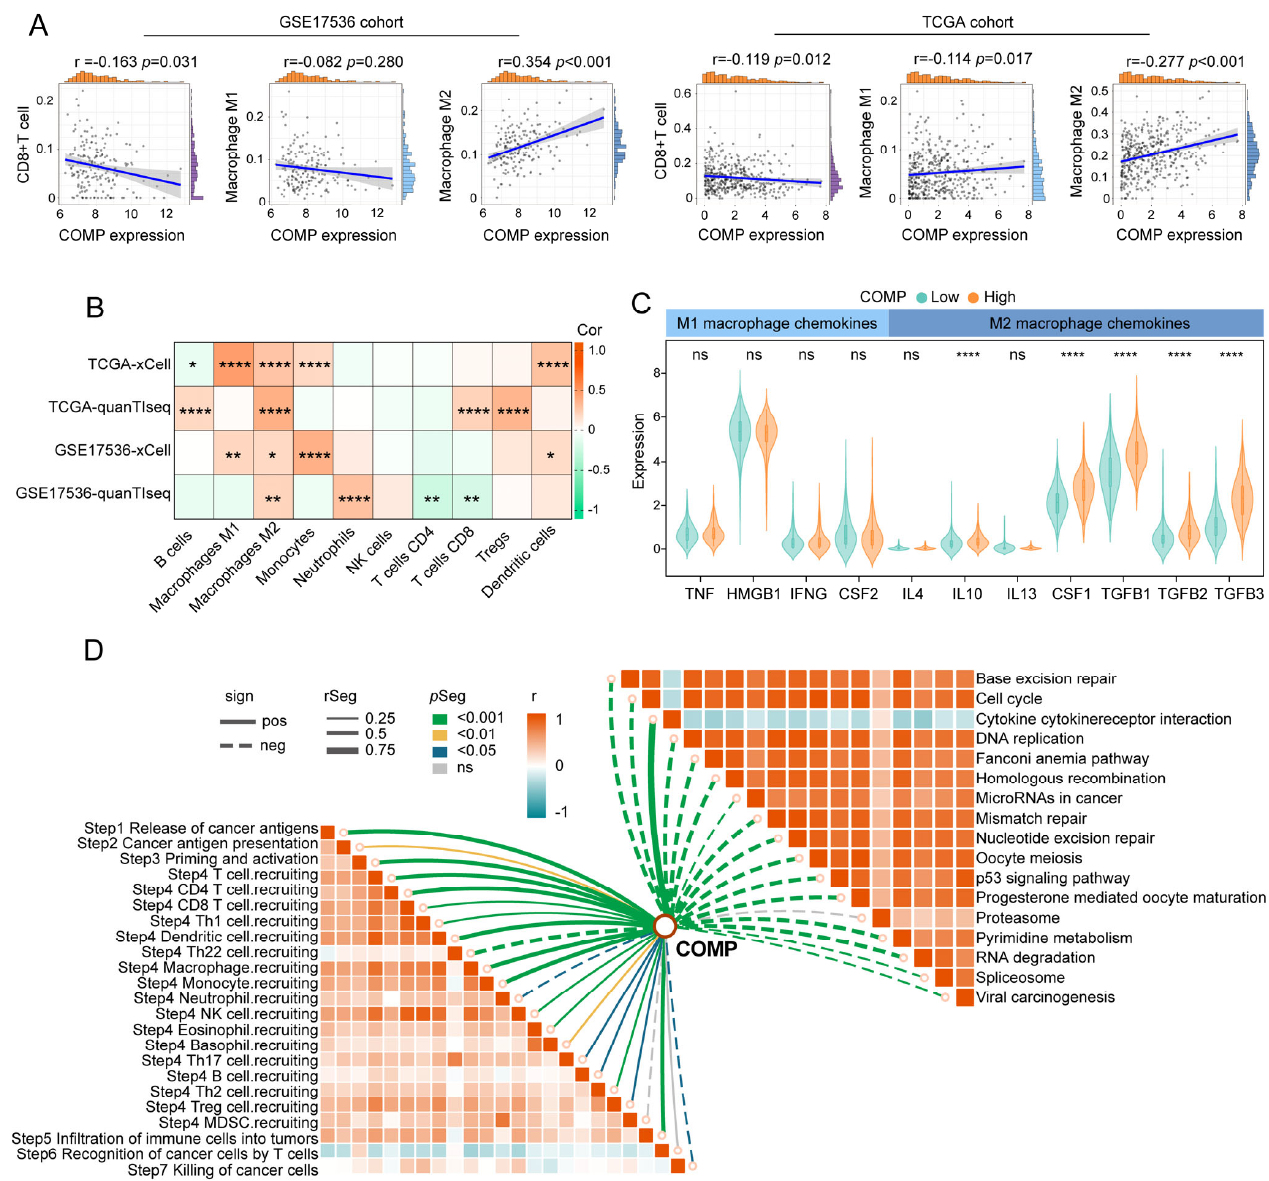
Figure 4. The immune landscape of COMP in colon cancer. ( A ) Correlations between COMP expression with CD8+T cells, M1 and M2 macrophage infiltration levels in the TCGA and GSE17536 datasets; ( B ) Heat map illustrating correlations between COMP expression and the infiltration levels of 10 immune cells estimated using xCell and quanTIseq algorithms; ( C ) Expression of representative macrophage chemokines between low ‐ and high ‐ COMP expression subgroups; ( D ) Associations of COMP expression with the enrichment scores of immunotherapy ‐ related pathways and the steps of the cancer immunity cycle (* p < 0.05; ** p < 0.01; **** p < 0.0001; ns, not significant).